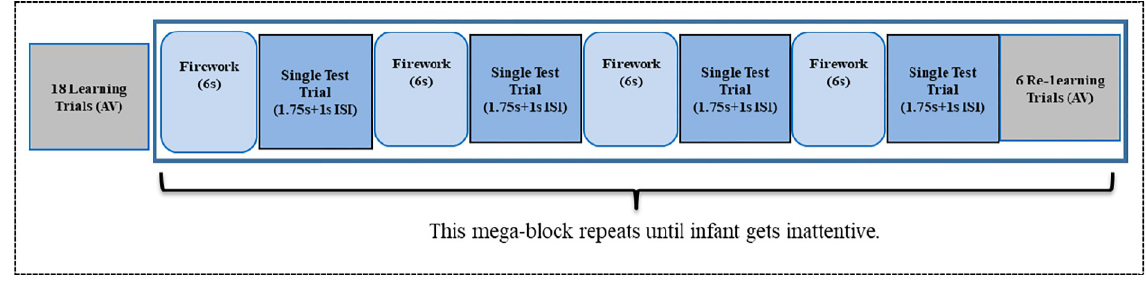
Fig 1. The fNIRS task